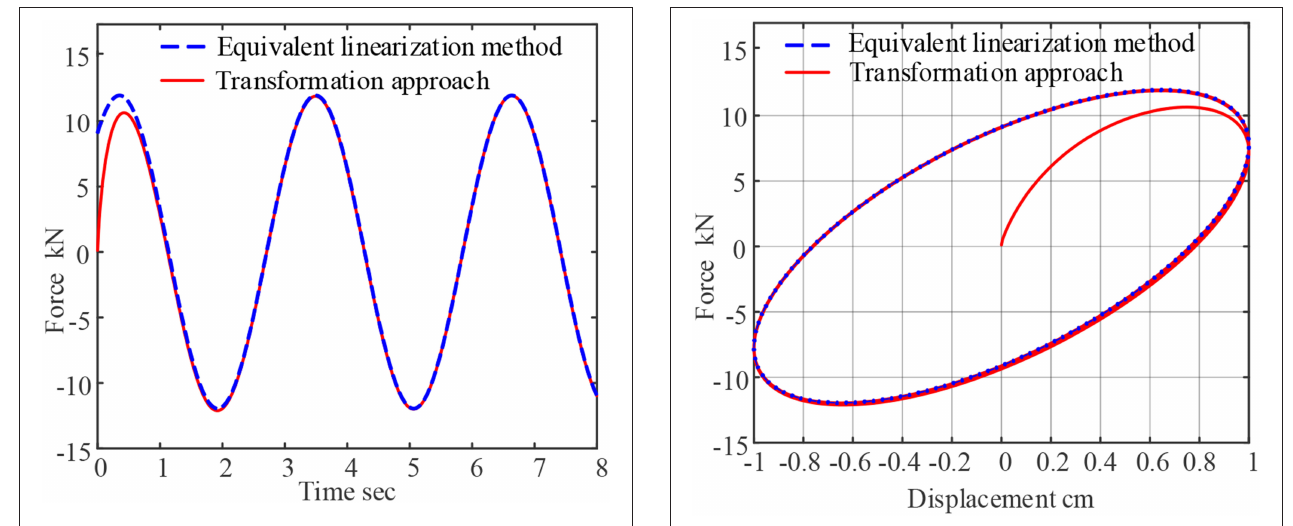
FIGURE 1 | Time history response of viscoelastic damper under harmonic load.